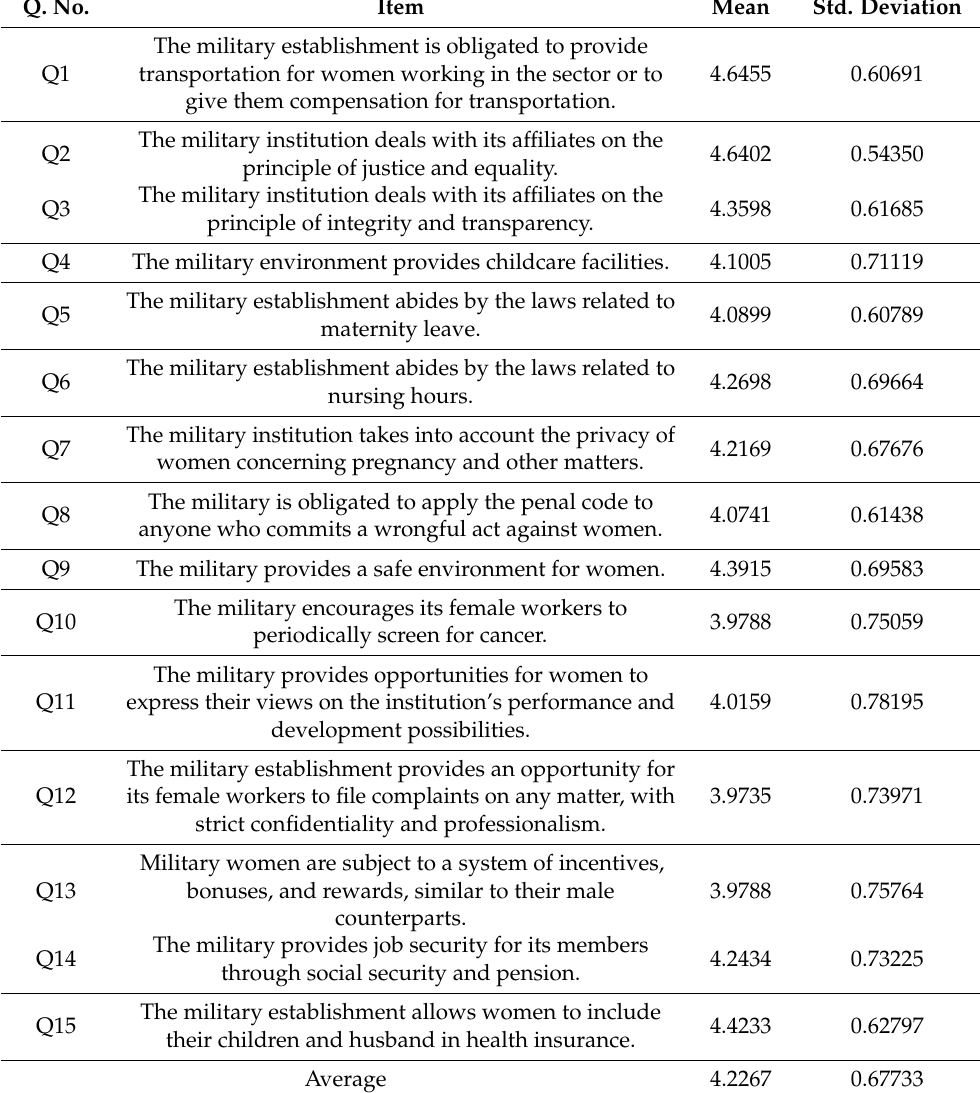
Table 1. Descriptive analysis of measurement items of work culture and